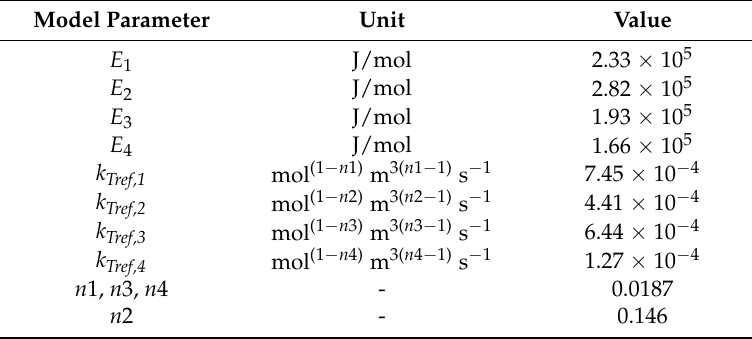
Table 3. Kinetic parameters